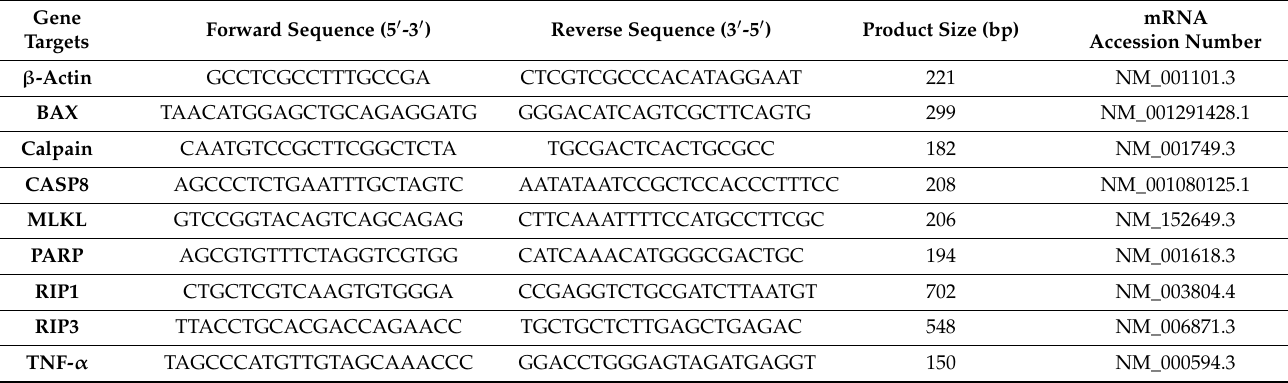
Table 1. Table of primer pairs for real-time RT-qPCR. Forward and reverse primer sequences, product size, and mRNA accession number for each gene